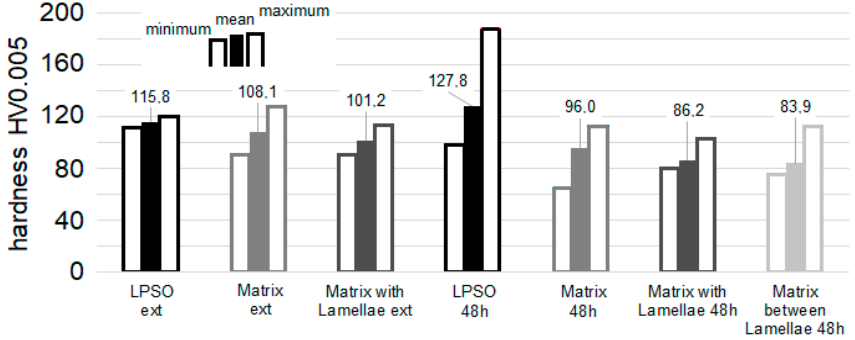
Figure 11. Minimum, mean and maximum values of the hardness HV0.005 in Mg ‐ Dy ‐ Nd ‐ Zn ‐ Zr alloy in the as ‐ extruded and the solution heat ‐ treated conditions at 500 °C for 48 h: in the blocky LPSO phases, in the matrix without and with LPSO lamellae and for 48 h in the matrix in between lamellae a wider distance apart.